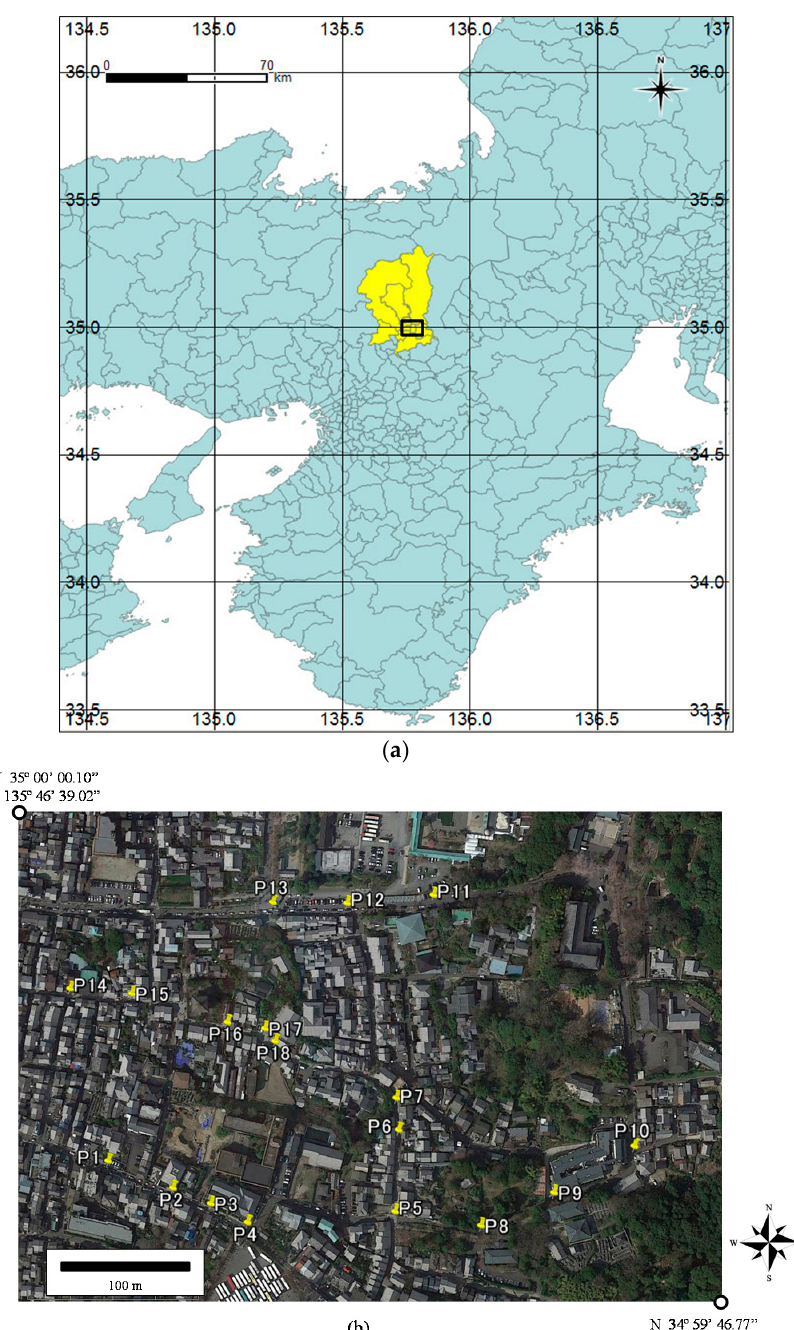
Figure 1. Study area: ( a ) Kyoto city in Japan, shown in yellow. The black rectangle corresponds to the area shown in ( b ). ( b ) Assessment positions are marked by yellow pins. Image is from Google Earth.